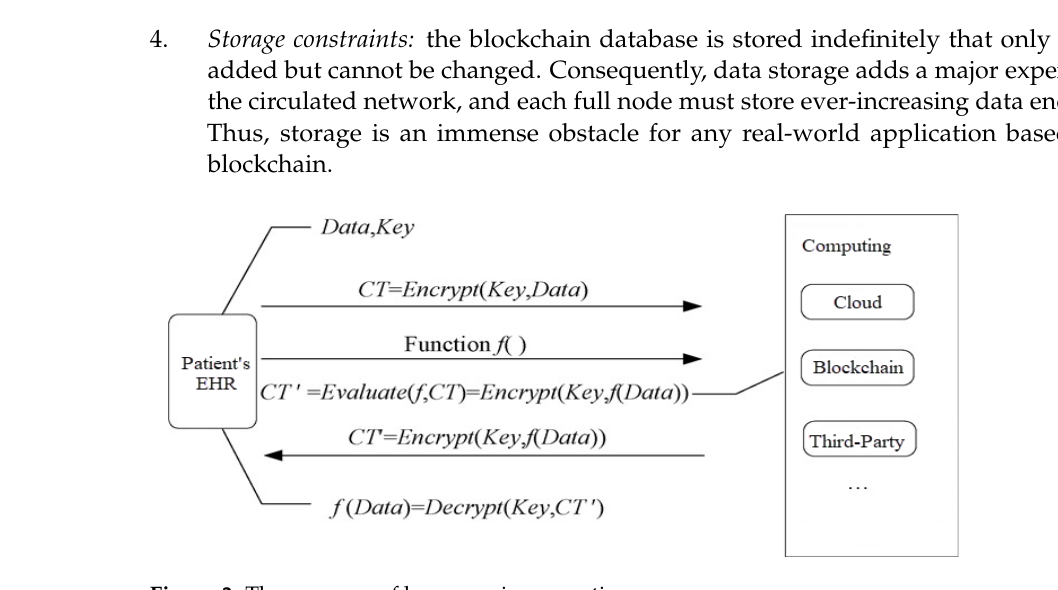
Figure 3. The progress of homomeric encryption. Table 2. The comparison of the implementation of blockchain technology and homomorphic en ‐ cryption.